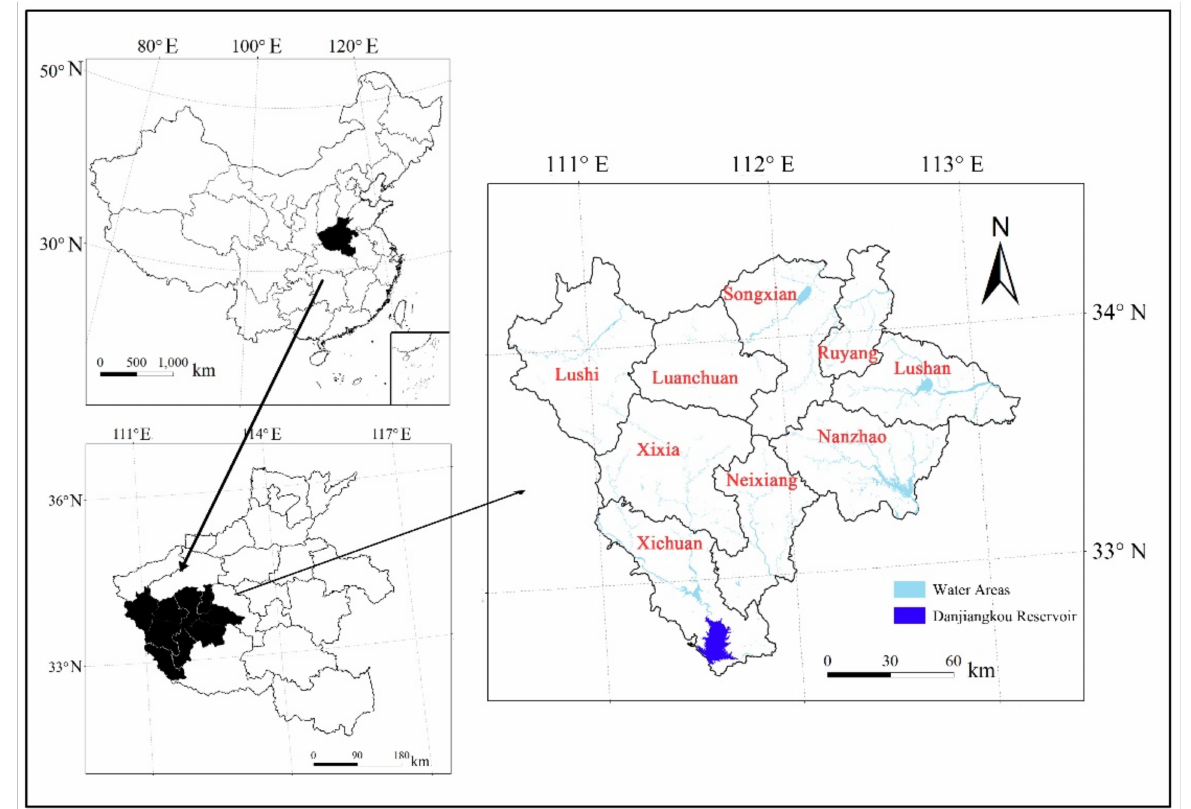
Figure 1. Location of the Funiu Mountain water conservation